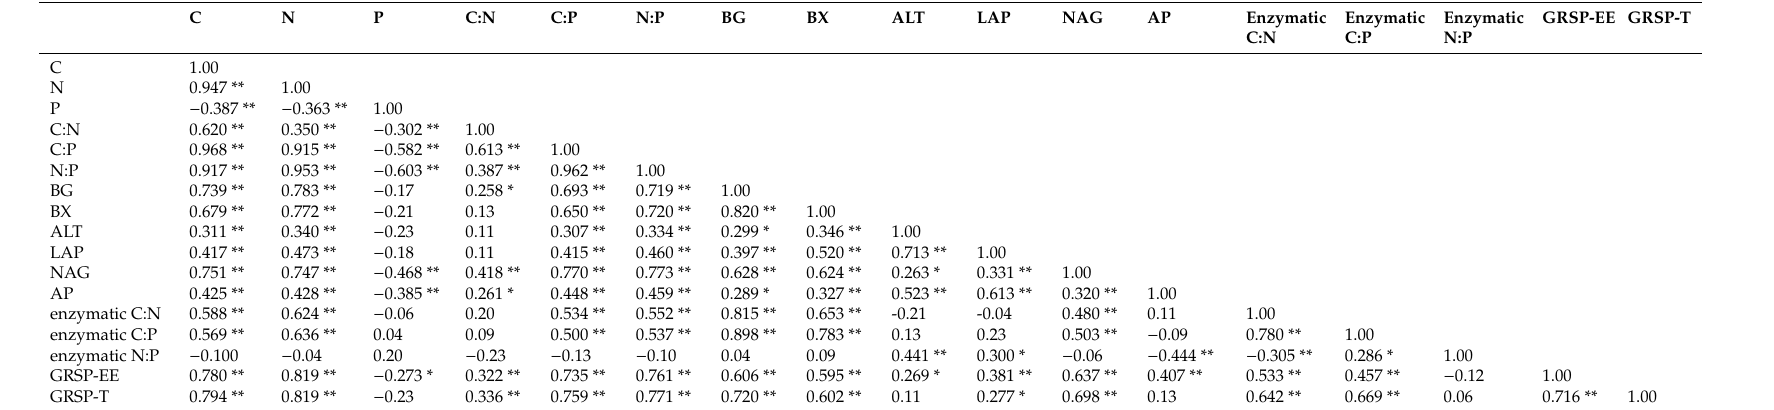
Table 4. Correlation coe ffi cients of contents and stoichiometry between soil properties and